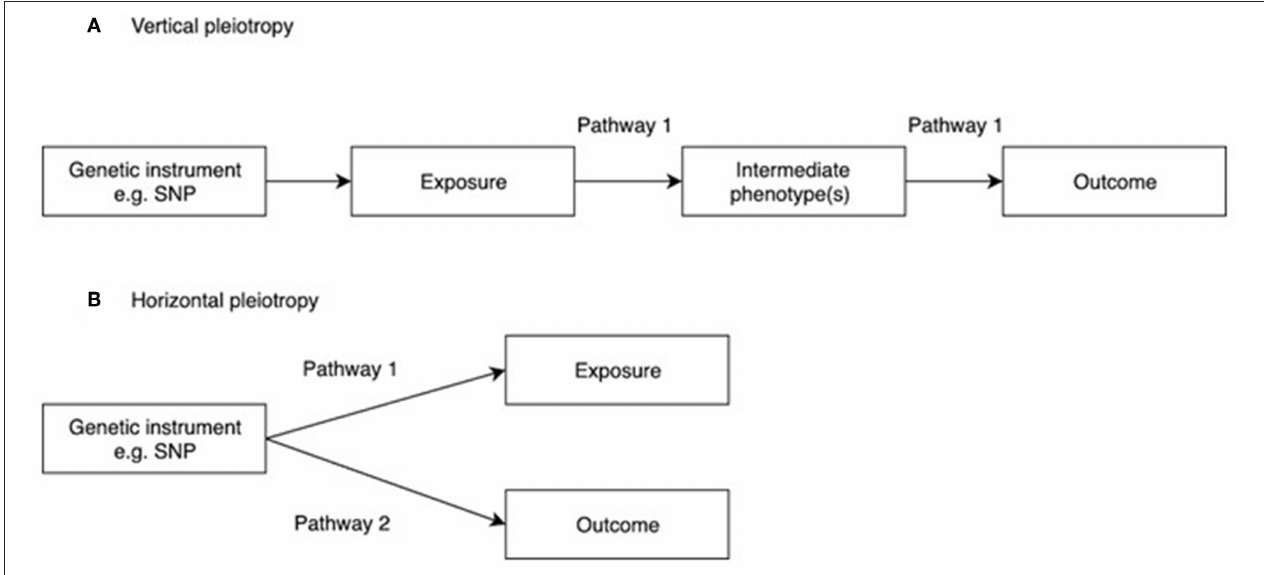
FIGURE 2 | Vertical and horizontal pleiotropy. (A) Vertical pleiotropy, which does not violate the MR assumption; (B) Horizontal pleiotropy, which violates the MR assumption.